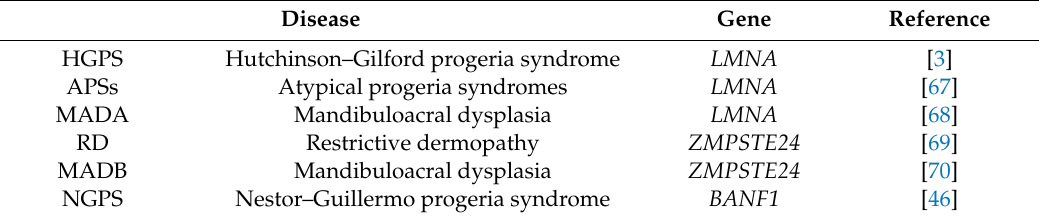
Table 1. Progeria syndromes caused by mutations in nuclear envelope